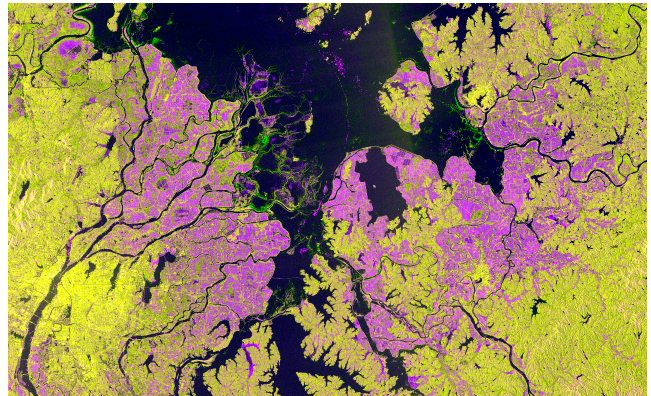
Figure 5. Flow chart of paddy rice image enhancement. “B1: Minimum” was the first band of enhanced image. For each pixel of the first band, its value was the minimum of the image set on paddy rice early growth stage for different types of paddy rice, then all the pixels constituted into the first band. “B2: Maximum” was the second band of enhanced image. For each pixel of the second band, its value was the maximum of the image set on paddy rice middle growth stage for different types of paddy rice. “B3: Difference” was the third band of enhanced image, which was the difference between the first band and the second band.